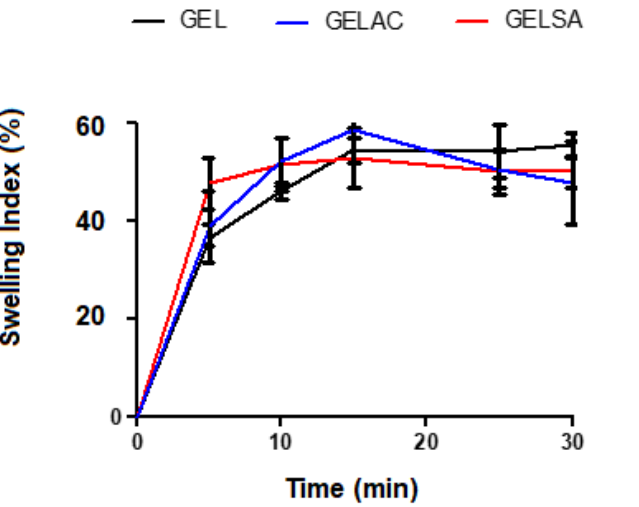
Figure 5. Swelling index (%) of GEL, GELSA, and GELAC biomembranes registered over time up to 30 min.